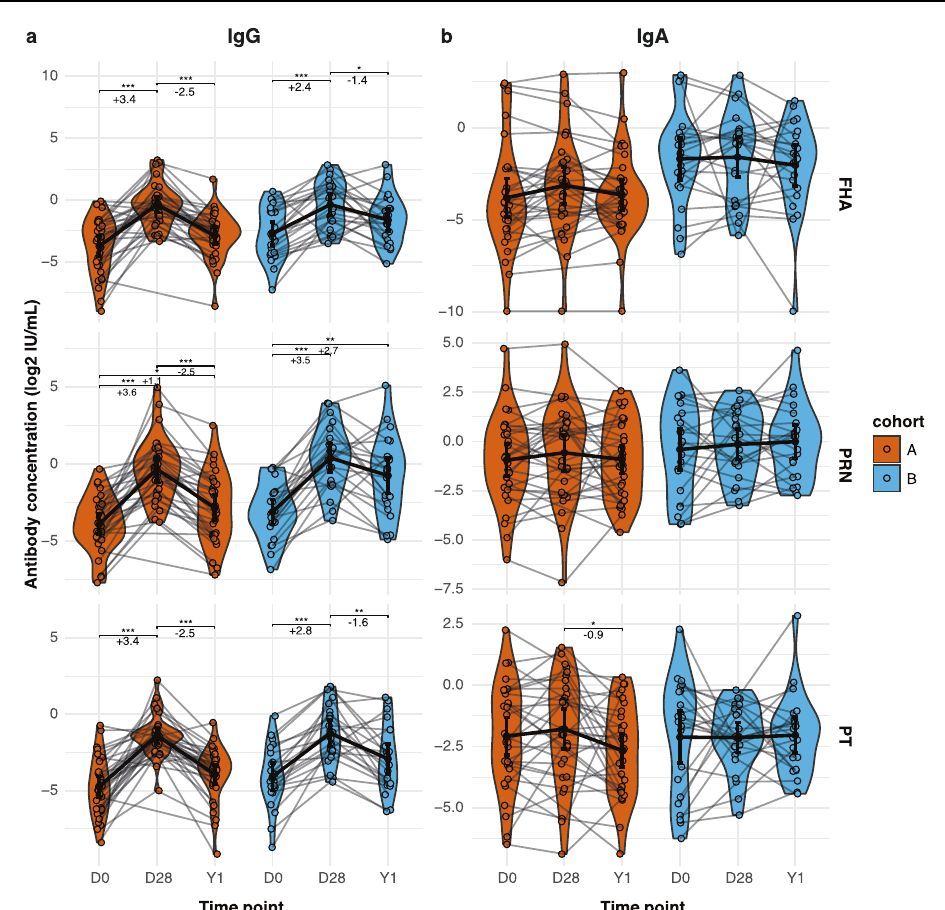
Fig. 5 | Effect ofTdap-IPVvaccinationonaP-antigen-speci fi c mucosalantibody concentrations. MLF was obtained from participants at baseline (D0) and 28 days (D28) and one year (Y1) after a dose of Tdap-IPV. Antibody concentrations in MLF were measured by multiplex immunoassay (MIA). a Log2-transformed concentra- tions of FHA-, Prn-, and PT-speci fi c IgG in international units (IU)/mL in MLF at the various sample timepoints. b Log2-transformed concentrations of FHA-, Prn-, and PT-speci fi c IgA in IU/mL in MLF at the various sample timepoints. Data are N =32 individualsforcohortAand N =22individualsforcohortB.Samplemeanswith95%